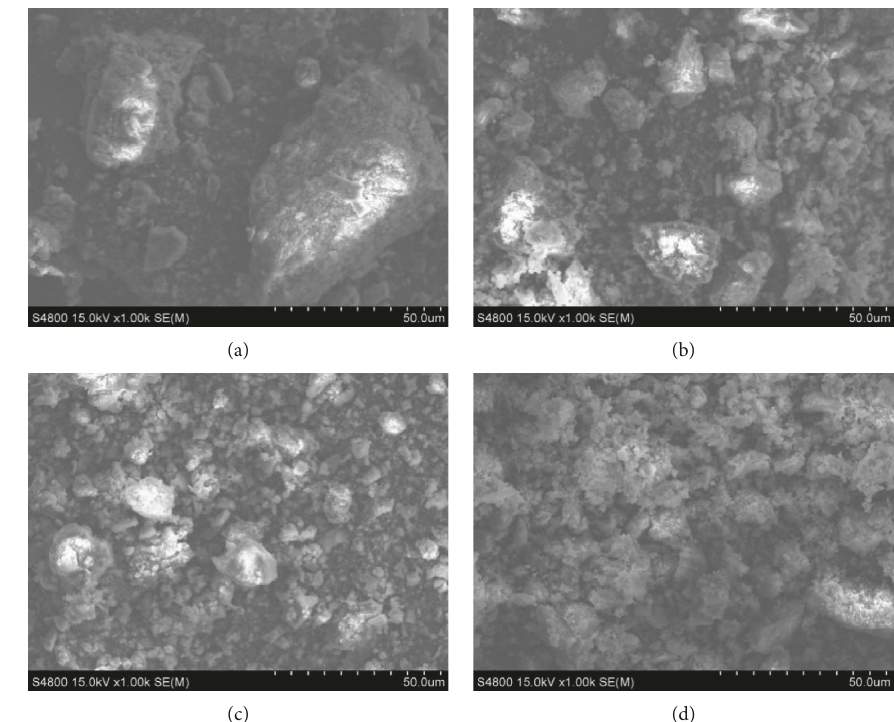
Figure 3: SEM images of CFBC desulfurization slag particles. (a) Raw slag; (b) T1 (13 min); (c) T3 (39min); (d) T5